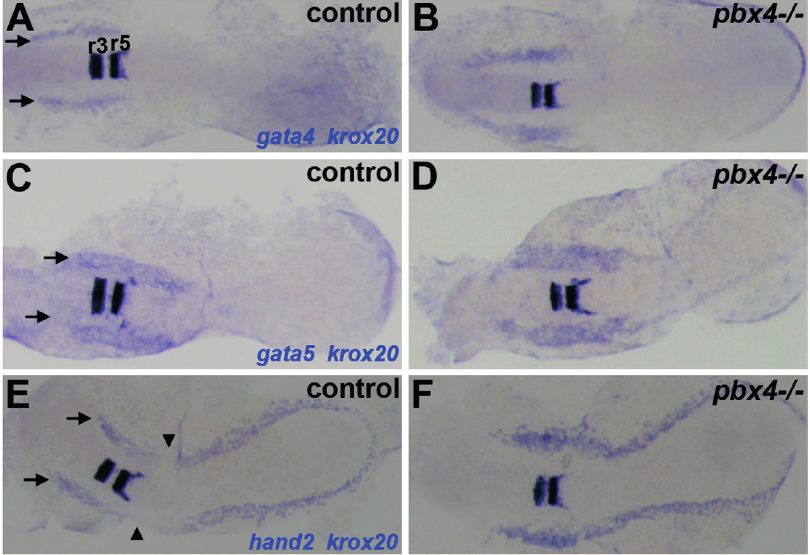
Figure 3. Early cardiomyocyte specification does not appear reduced in pbx4 mutant embryos. ( A – F ) RNA in situ expression at the 10 s stage of cardiomyocyte specification genes ( A – B ) gata4 , ( C – D ) gata5 , and ( E – F ) hand2 in the anterior lateral plate mesoderm (ALPM) in ( A , C , E ) control and ( B , D , F ) pbx4 b557 -/- embryos. Expression of the Pbx-dependent gene krox20 , marking hindbrain rhombomeres 3 and 5 (r3, r5 in A ),